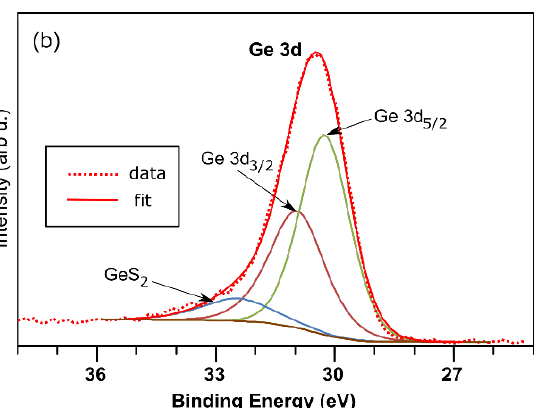
Figure 2. XPS spectra of ( a ) the S 2p and ( b ) Ge 3d core levels for the GeS sample. Positions of the components for S 2p are 162 eV and 163.2 eV, for Ge 3d are 30.85 eV, 30.15 eV and an extra at 32.35 eV coming from GeS 2 compound formed at the surface.